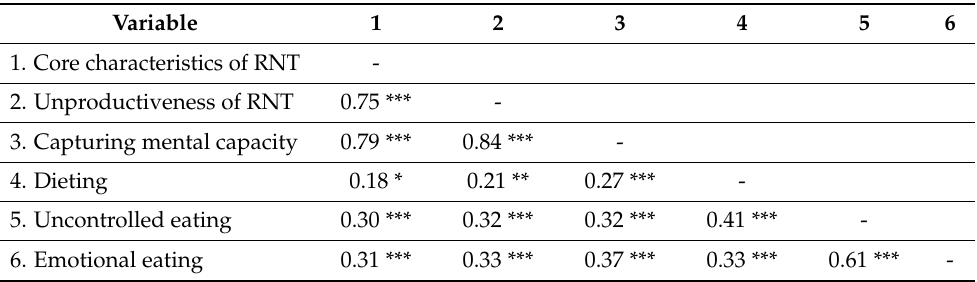
Table 1. Correlations of study variables.